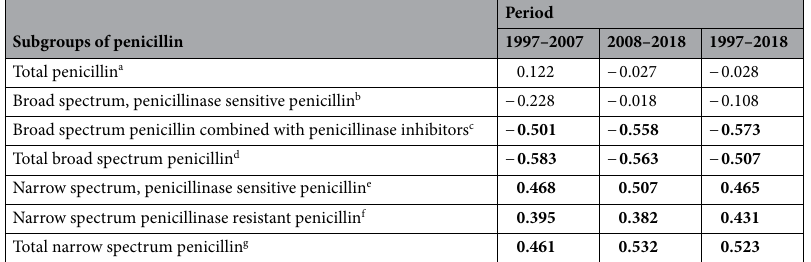
Table 4. Correlations of antibiotic consumption and prevalences of T1DM (0–19 years). ATC code: a J01C; b J01CA; c J01CR; d J01CA + J01CR; e J01CE; f J01CF; g J01CE + J01CF. r values of significant correlations are given in